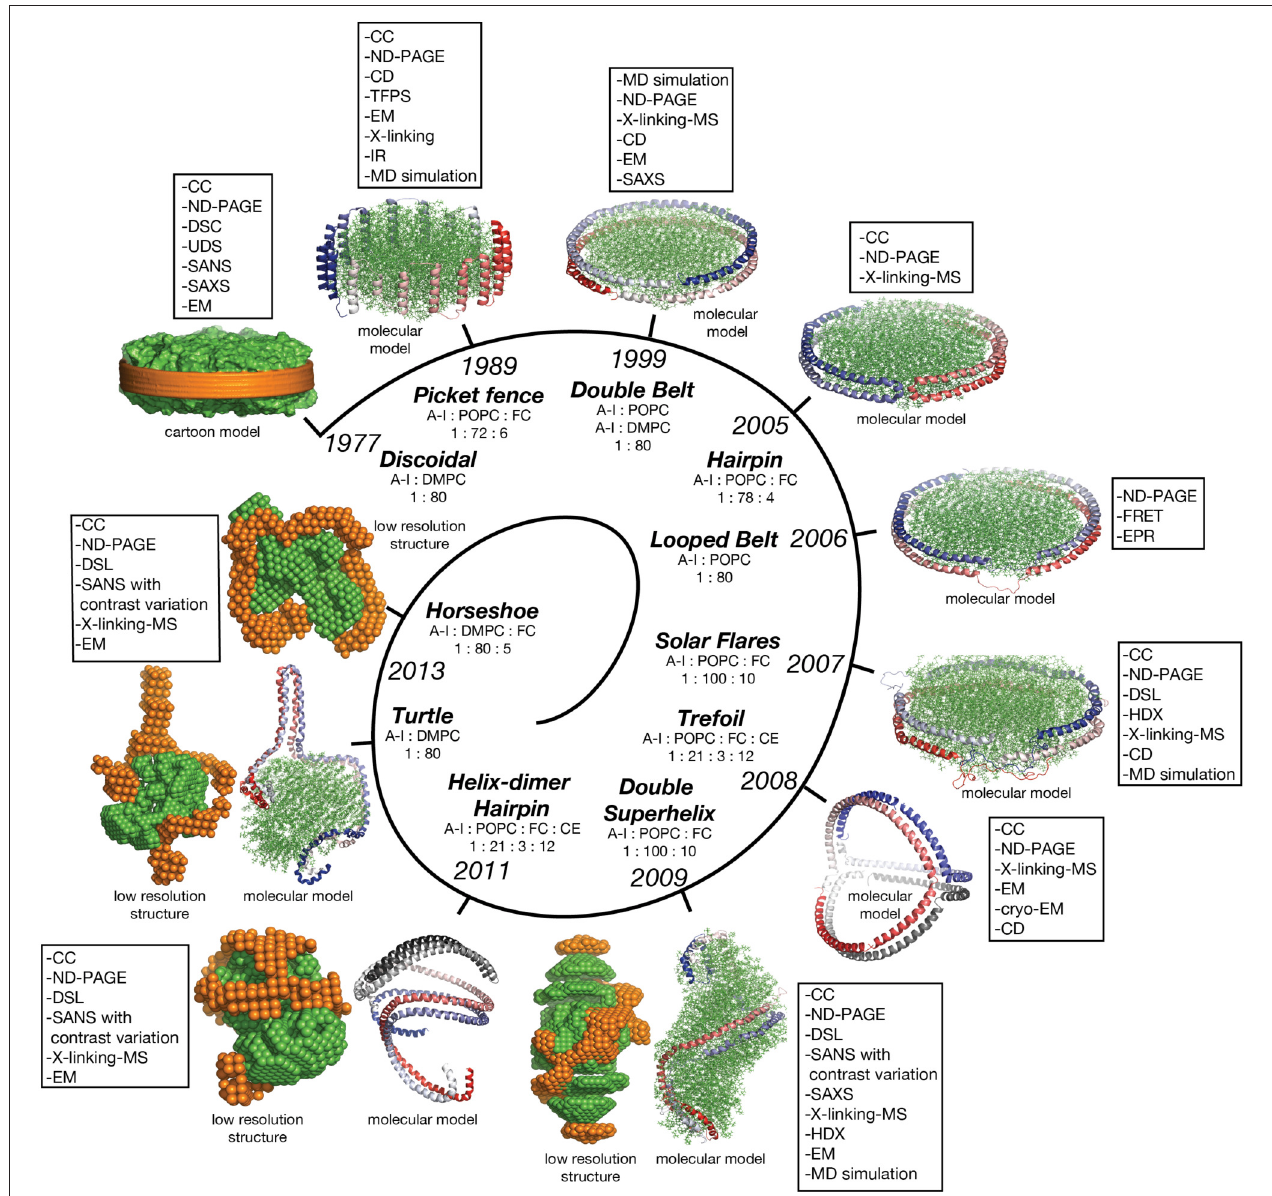
FIGURE 9 | Historical perspective of the development of various nHDL and sHDL models. The map displays in chronological order various models of nHDL and sHDL developed in the last four decades. Alongside each model are listed various biophysical methods used to develop a particular model. While some of the models were not initially developed by incorporating data from all experimental techniques listed, overtime, some of the listed techniques were used to support that particular model. The low resolution structures obtained from SANS with contrast variation are displayed next to the nHDL and sHDL models derived from